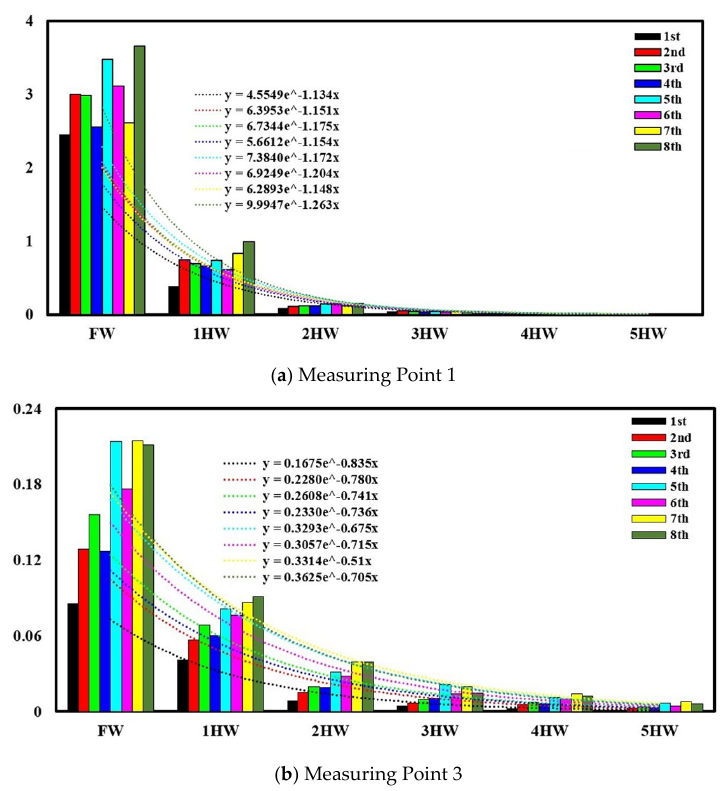
Figure 9. Variations of the fundamental and multiple harmonic amplitudes of each measuring point.